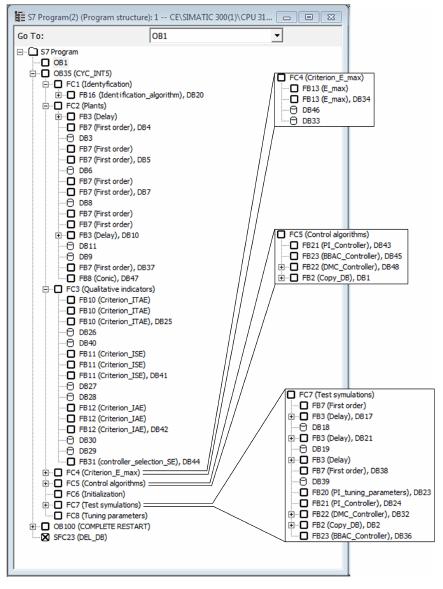
Figure 6: Program structure in the